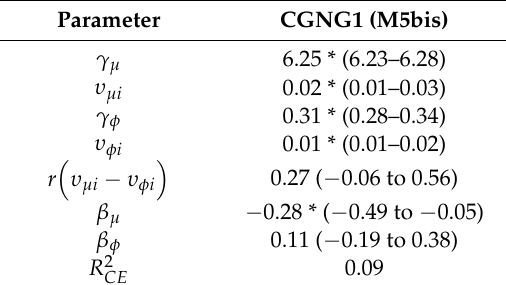
Table A2. Posterior means (and 95% credible intervals) of fixed effects, random effect variances, correlations between random effects, and regression weights of CE i on µ i and φ i estimated for models 5bis. Mean fixed effects and random variances are shown in raw metrics, while correlations and regression weights are shown in within-level standardized metrics.